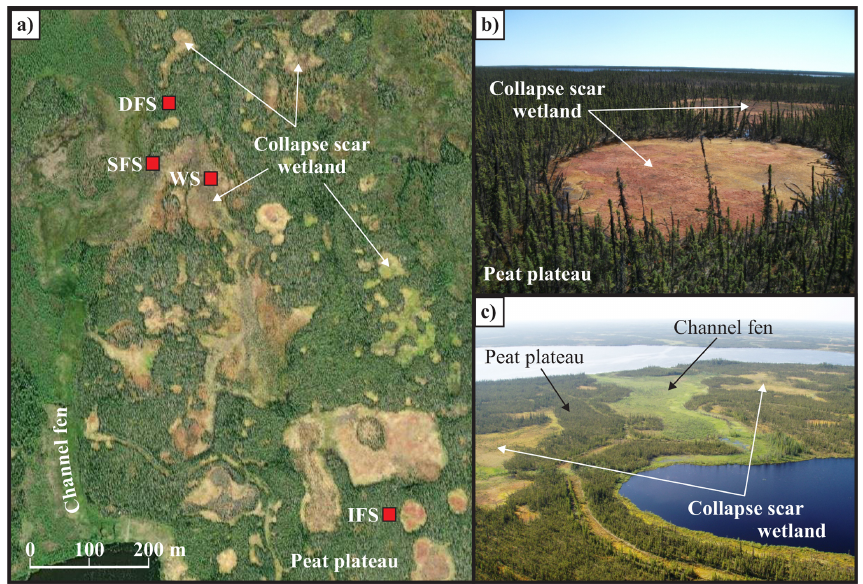
Figure 3. WorldView 2 satellite image (a) and oblique aerial photographs (b, c) over Scotty Creek, Northwest Territories. The satellite image also shows the locations of the Dense Forest Station (DFS), Sparse Forest Station (SFS), Wetland Station (WS), and Intermediate Forest Station (IFS) micrometeorological stations. The oblique aerial photographs show the land cover types that dominate lowlands with discontinuous permafrost in the Taiga Plains, including peat plateau (permafrost), collapse scar wetland, and channel fen.